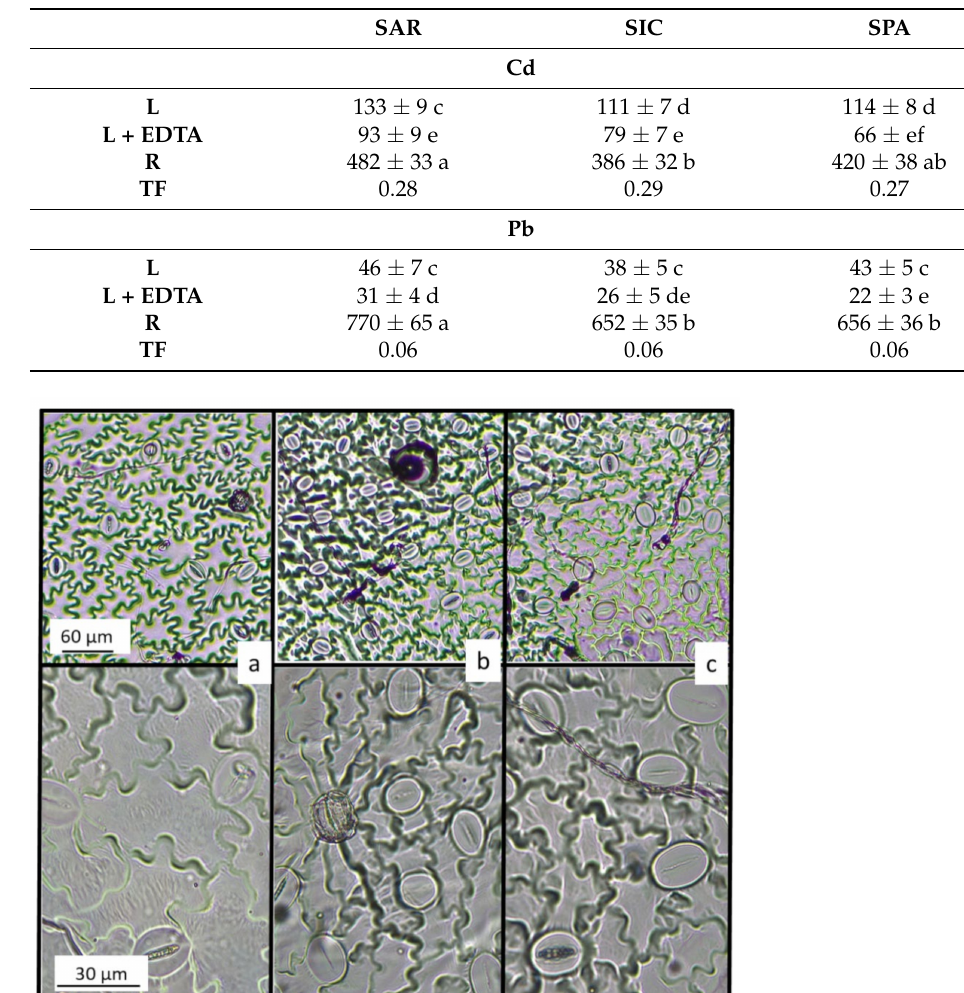
Table 1. Element concentrations (mg kg − 1 , mean ± SD, n = 7) in shoot without washing (L), after EDTA washing to eliminate the apoplastic fraction (L+ EDTA; see par. 2.3), and root (R) in the three cultivars Sardo (SAR), Siciliano (SIC), and Spagnolo (SPA); the translocation factor (TF = (L)/(R)) was also calculated for the three cultivars. Different letters indicate significant differences ( p < 0.05) according to Tukey’s test.